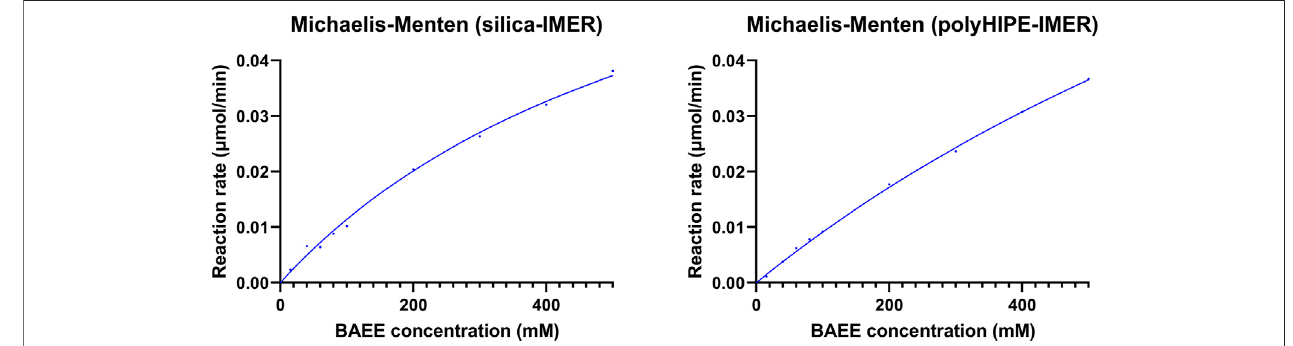
FIGURE 3 | Kinetic pro fi les of papain immobilized on the silica and polyHIPE supports.